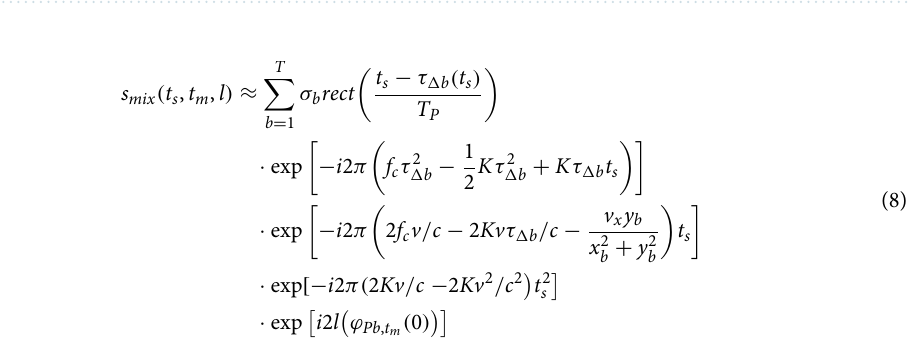
Figure 2. The comparison between the theoretical values of the instantaneous azimuth and Taylor series